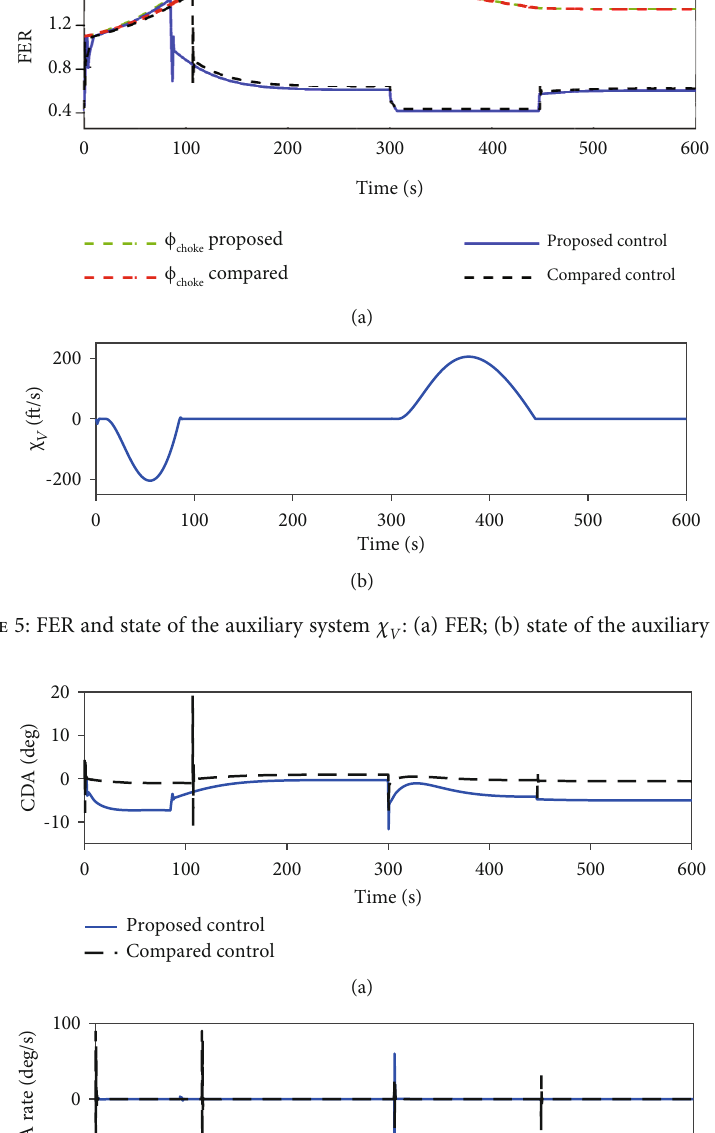
Figure 6: CDA and CDA rate in the comparison simulation: (a) canard de fl ection angle; (b) canard de fl ection angle